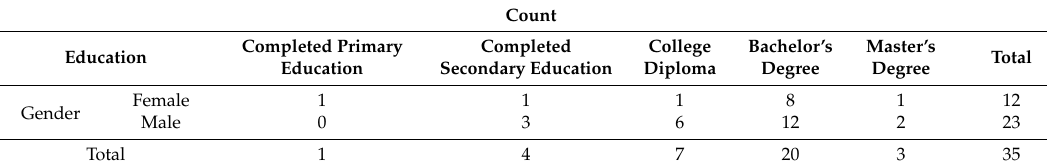
Table A1. Gender * Education crosstabulation.